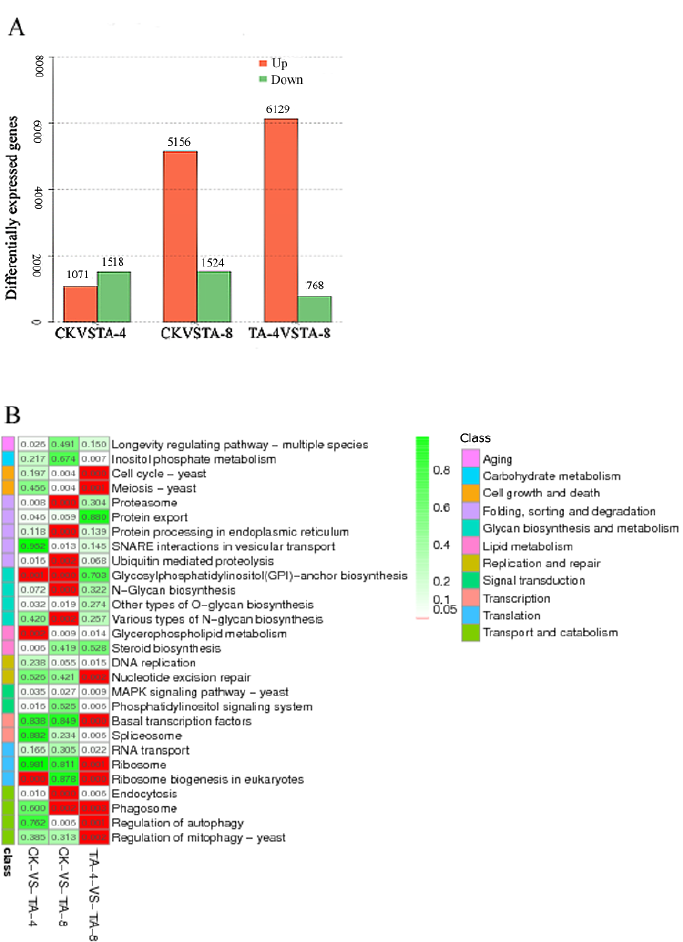
Figure 4. The differentially expressed unigenes and the pathway enrichment in different groups: ( A ) Differentially expressed unigenes; ( B ) KEGG enrichment. ( A ) Differentially expressed unigenes; ( B ) KEGG